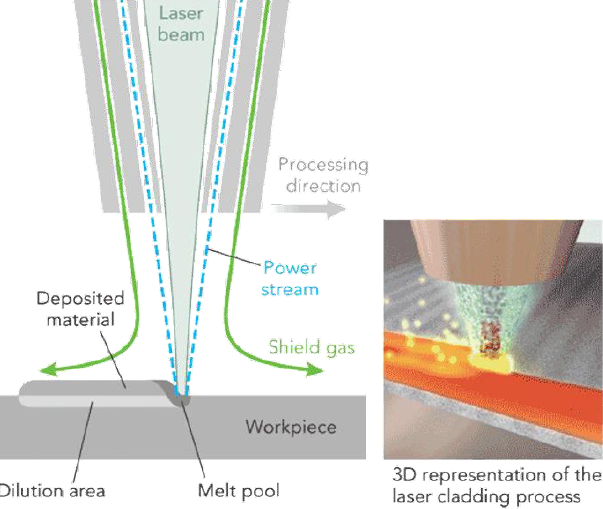
Figure 1. Schematic representation of coaxial LMD process with powder (LMD-p) [3] (With per- mission of TRUMPF Laser- und Systemtechnik